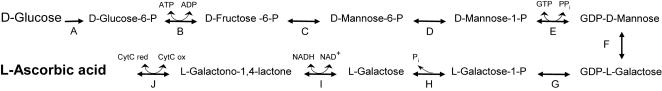
Ascorbic acid biosynthetic pathway.Schematic representation of the pathway of L-AA production from D-glucose in plants. The following enzymes are involved: A, hexokinase (2.7.1.1), B, glucose-6-phosphate isomerase (5.3.1.9), C, mannose-6-phosphate isomerase (5.3.1.8), D, phosphomannomutase (5.4.2.8), E, mannose-1-phosphate guanylyltransferase (2.7.7.22), F, GDP-mannose-3,5-epimerase (5.1.3.18), G, GDP-L-galactose phosphorylase (E.C.C not assigned), H, L-Galactose 1-phosphate phosphatase (3.1.3.25), I, L-galactose dehydrogenase, J, L-galactono-1,4-lactone dehydrogenase (1.3.2.3).